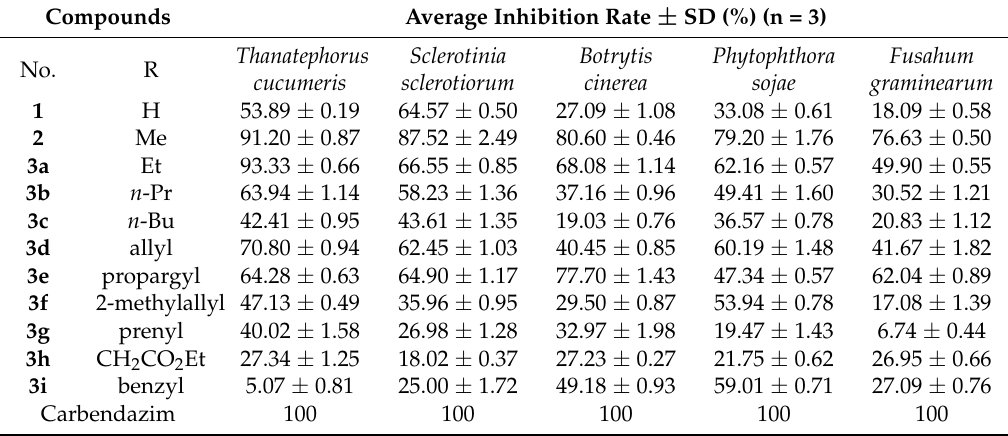
Table 1. Preliminary antifungal activities of all title compounds against five fungi at 100 µg/mL.